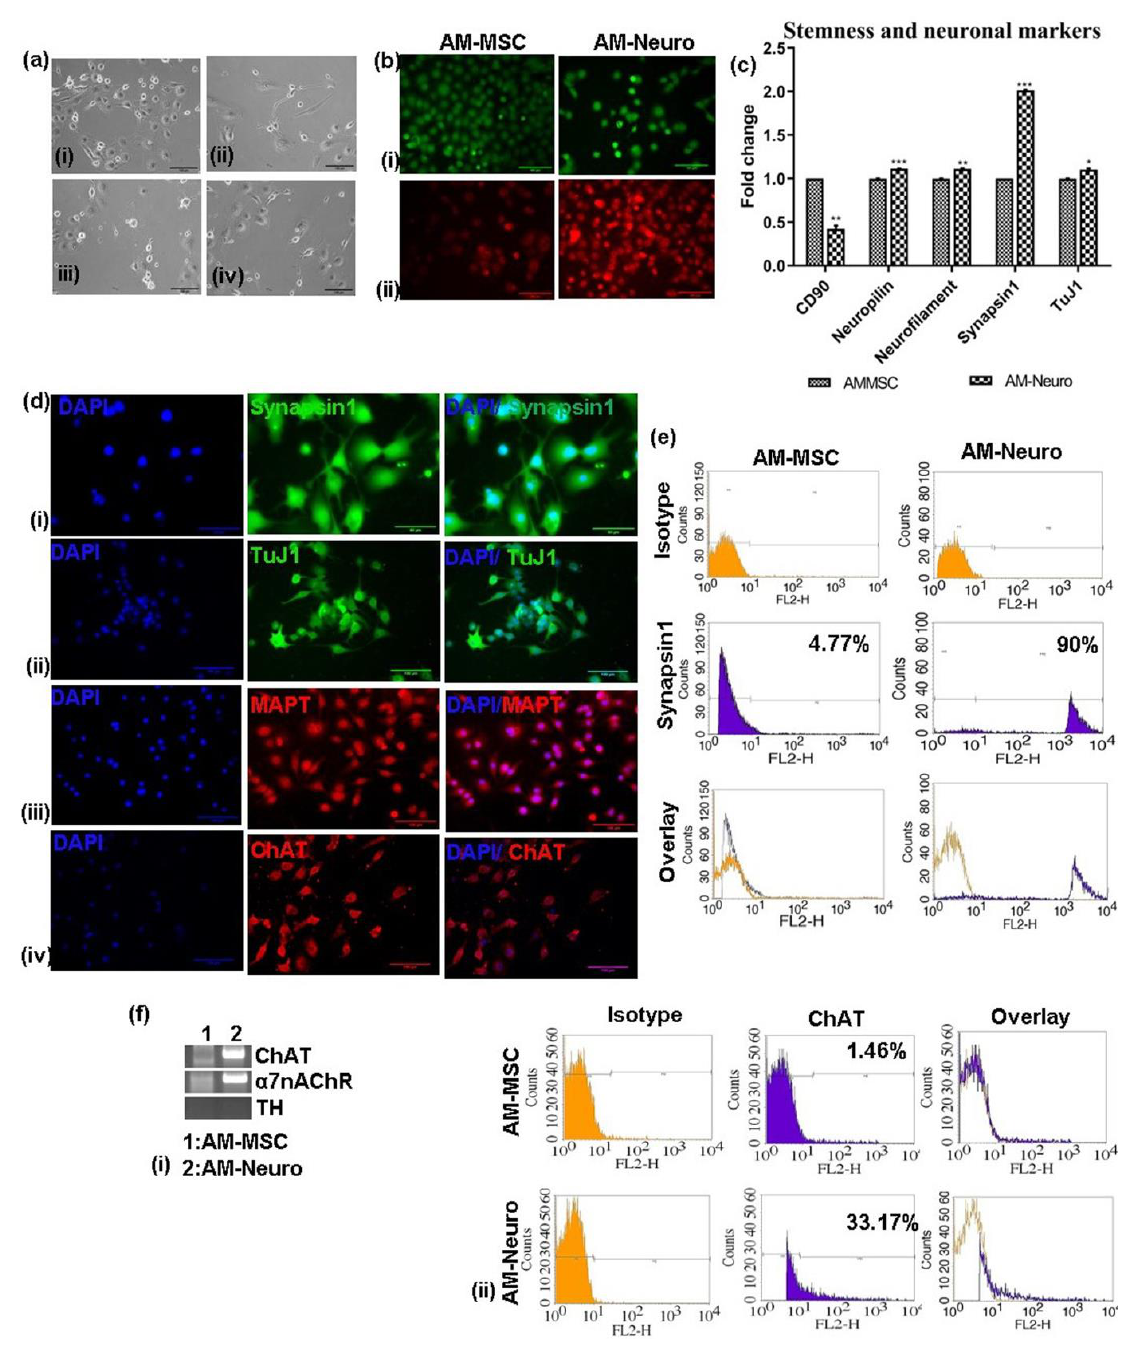
Figure 2. Differentiation of AM-MSC into neural cell types and its characterization. ( a ) Photomicrographs of neural cell types derived from AM-MSC upon culturing in induction medium, ( i ) neurons, ( ii ) microglia, ( iii ) oligodendrocyte, ( iv ) astrocytes (20× magnification, scale bar = 100 µm). ( b ) Microscopic images of cells stained with ( i ) Calcein-AM staining the intracellular esterases, ( ii ) TMRE staining the active mitochondria (20× magnification, scale bar = 100 µm). ( c ) qRT-PCR analysis show- ing downregulation of MSC marker-CD90 and upregulation of neural markers: neuropilin, neuro- filament, synapsin1 and tuj1 in the differentiated cells. Data are represented as mean with SEM ( n = 3), * p < 0.05, ** p < 0.01 *** p < 0.001. ( d ) Immunofluorescence analysis performed on AM-Neuro cells for neural markers ( i ) synapsin1, ( ii ) tuj1, ( iii ) MAPT and ( iv ) ChAT (20× magnification, scale bar = 100 µm). ( e ) Flow cytometry analysis of the AM-MSC and AM-Neuro cells showing 90% of cells